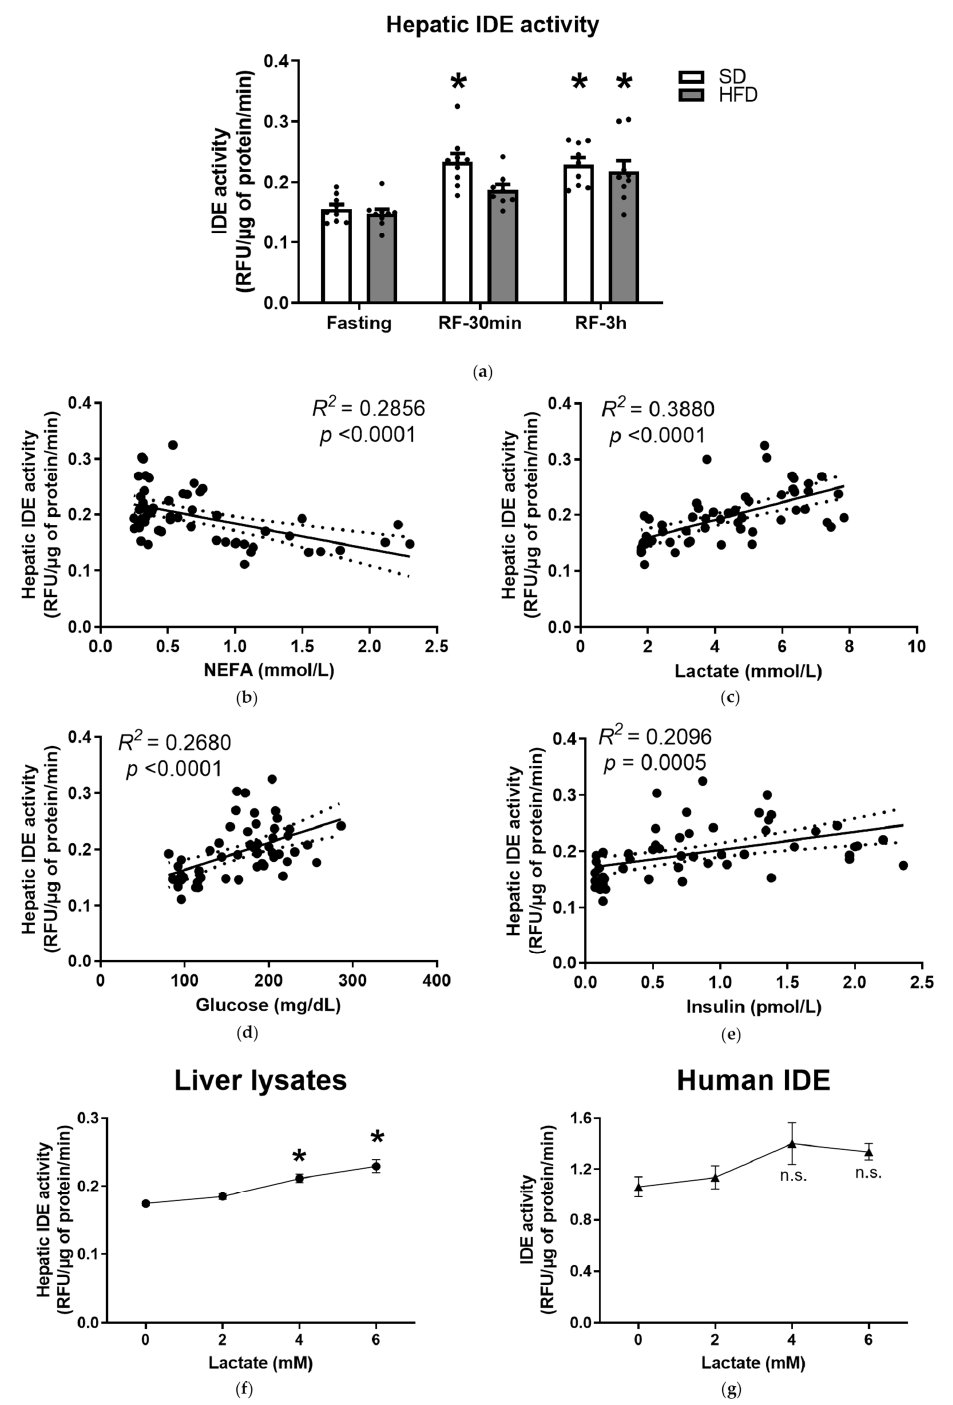
Figure 2. Effects of feeding and refeeding on hepatic IDE activity. ( a ) IDE activity in lysates from livers of mice fed an SD or HFD, during the indicated fasting or refeeding conditions. Data are the means ± SEM. N = 9 mice per condition. * p < 0.05 vs. ( b – e ) ANOVA and regression analyses between IDE activity in liver lysates and levels of different plasma biochemical parameters analytes. Bivariate analyses were performed on the data from mice fed an SD and HFD, during fasting or refeeding conditions. Correlations between hepatic IDE levels and NEFA ( b ), lactate ( c ), glucose ( d ), and insulin ( e ). The R 2 and the statistical significances ( p ) values are indicated in the figure. ( f – g ) Effects of lactate on IDE activity. ( f ) IDE activity in the absence or presence of different concentrations of lactate in lysates from fasted livers of the group of mice fed an SD for 8 weeks. Data are the means ± SEM. N = 3 livers of mice per condition in duplicate. * p < 0.05 vs. no lactate by ANOVA. ( g ) Activity of purified human recombinant IDE in the absence or presence of different concentrations of lactate. Data are the means ± SEM. N = 3. n.s., not statistically